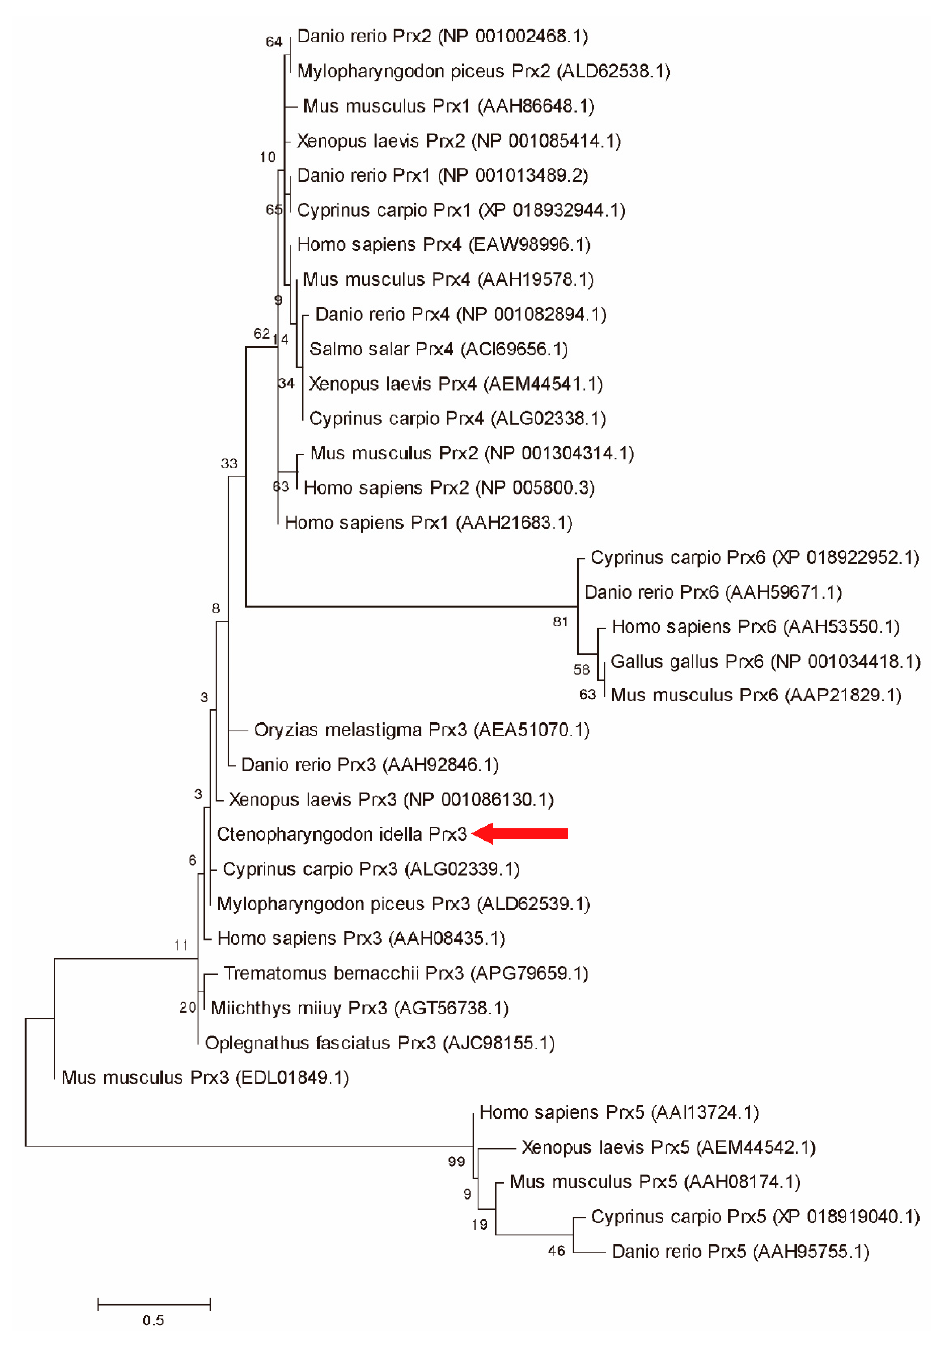
Figure 2. Maximum Likelihood (ML) phylogenetic tree analyses of CiPrx3 with other Prx proteins from other species. The confidence in each node was assessed by 10,000 bootstraps.